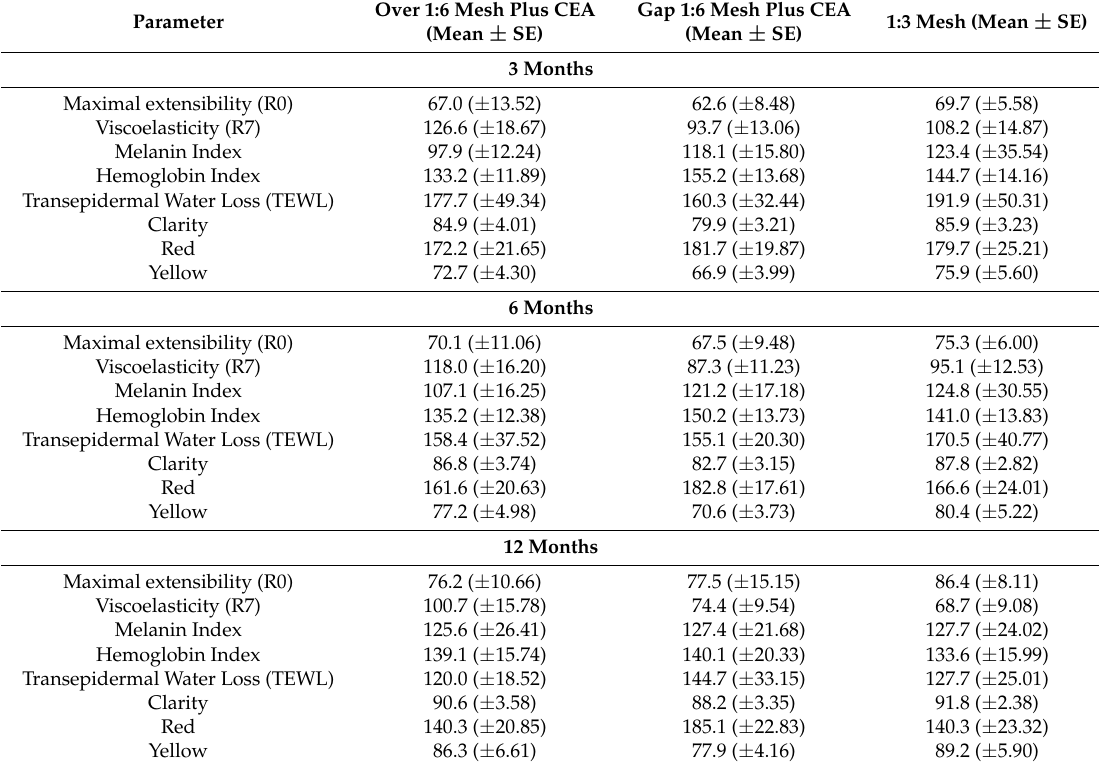
Table 3. Value of each parameter (3, 6 and 12 months).